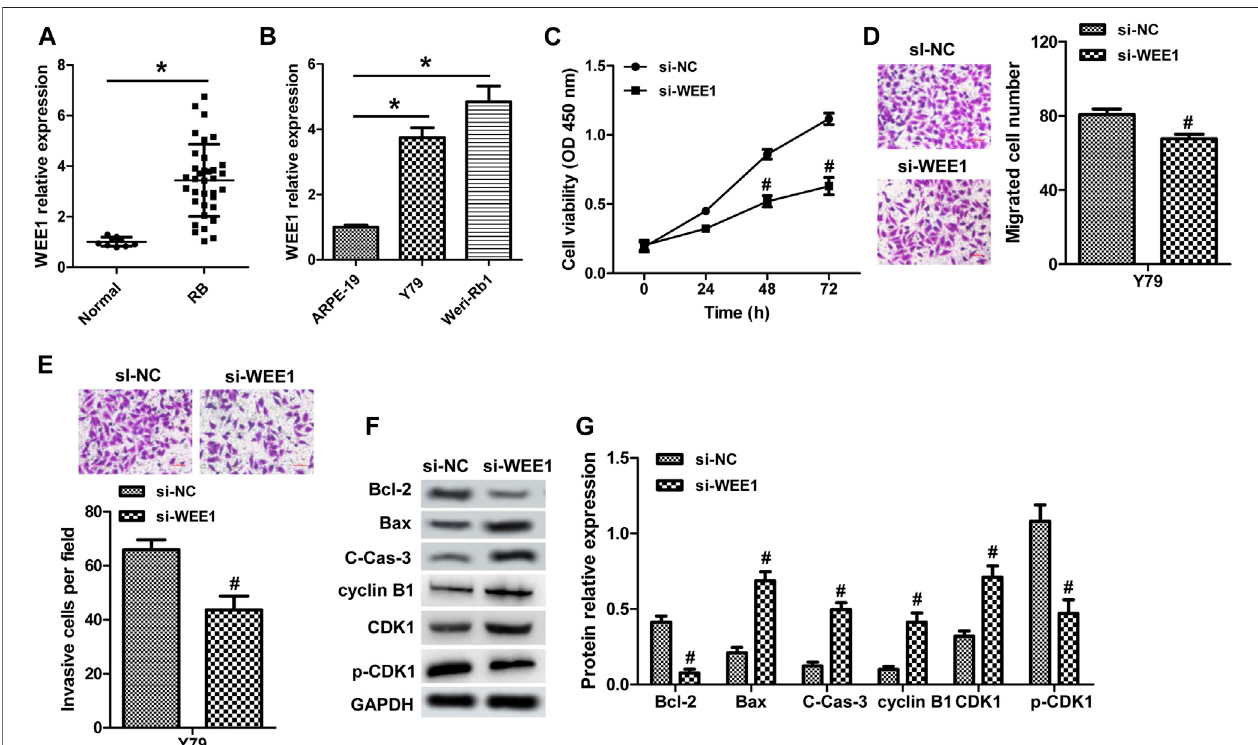
FIGURE 5| WEE1 promotes the malignant phenotypes ofRB. (A) WEE1 expression in 35RB and nine normal tissue sampleswasdetected by real-time PCR. (B) The expression of WEE1 in RB cell lines and ARPE-19 cells. (C) Y79 cells transfected with WEE1 siRNA showed inhibited cell proliferation compared with the control siRNA group. The migration (D) and invasion (E) of Y79 cells transfected with WEE1 siRNA or control siRNA were analyzed by transwell. (F,G) Western blot assay for apoptosis- and cell cycle – related proteins in Y79 cells. * p < 0.05 vs. the normal group or ARPE-19 cells; # p < 0.05 vs. the si-NC group.